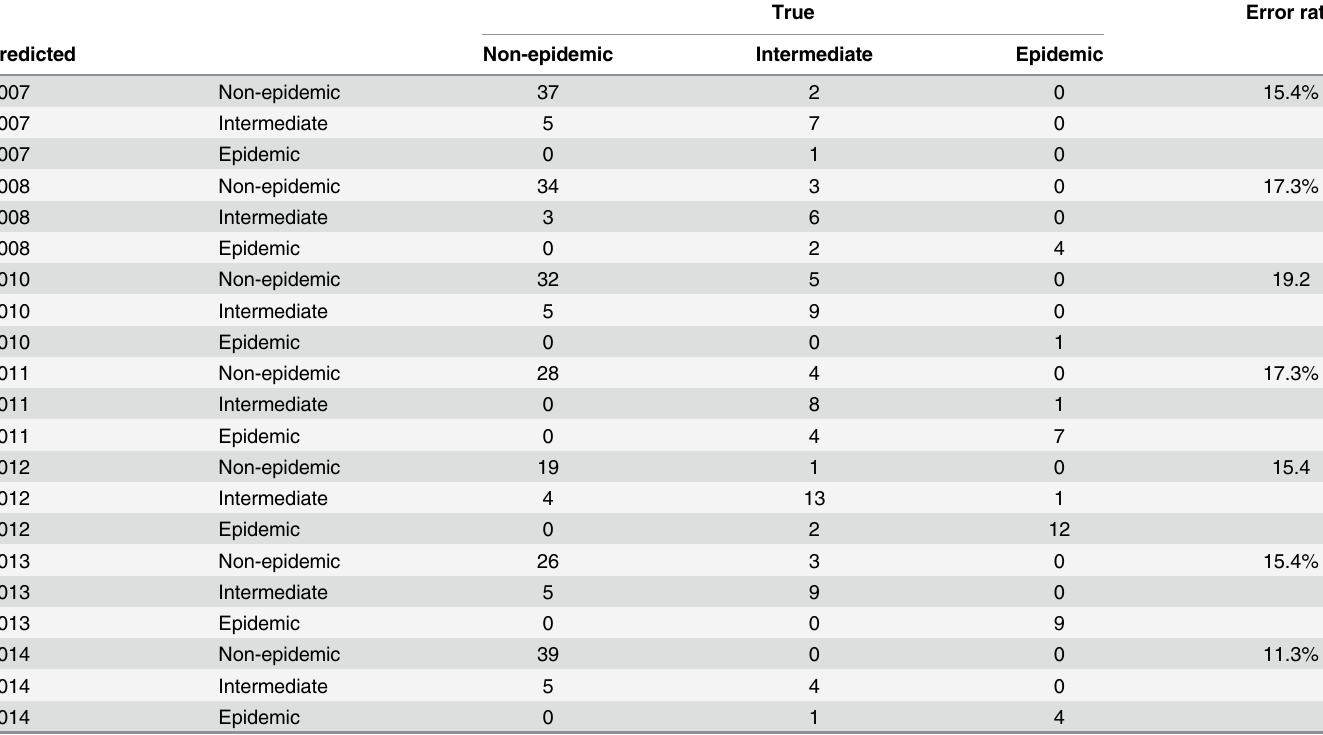
Table 6. Predictive LDA- Confusion matrix, for each predicted year.